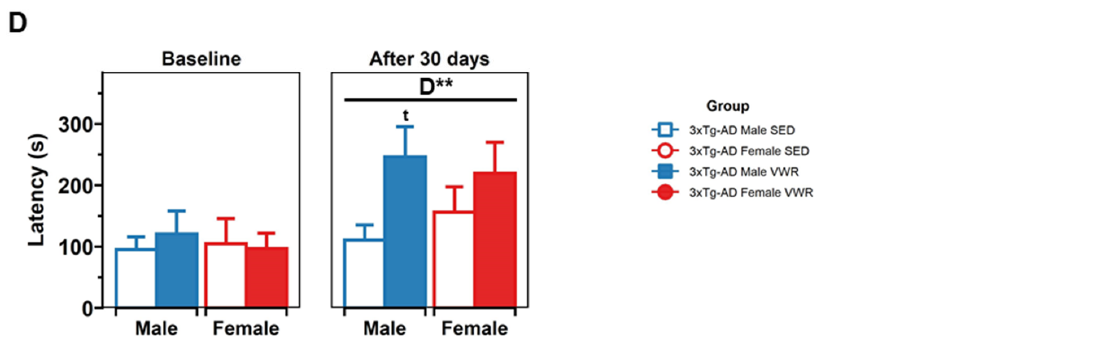
Figure 6. Rotarod test. ( A ). Learning phase. ( B ). Accelerated phase (pooled values). ( C ). Accelerated